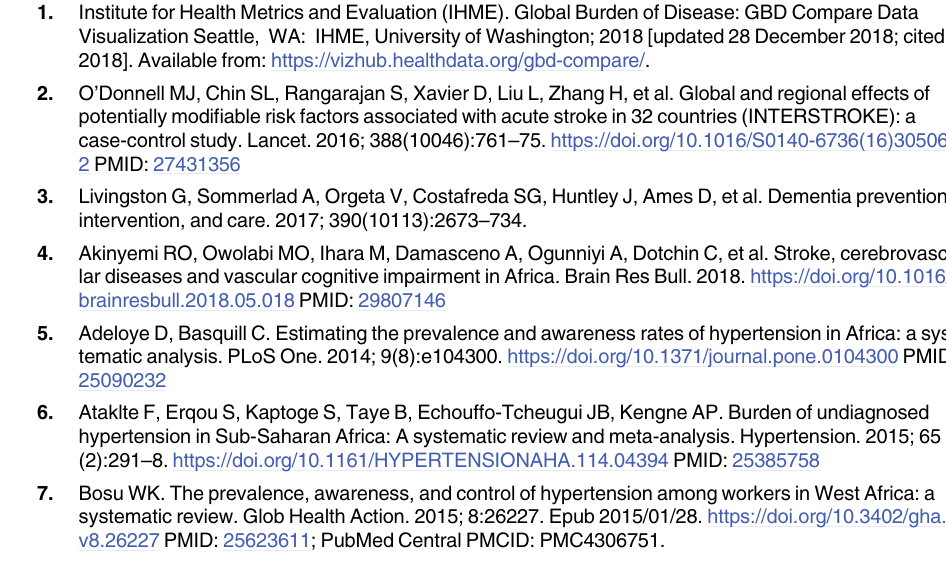
S3 Fig. Influence analysis omitting one study at a time from meta-analysis. S4 Fig. Funnel plot for studies on the prevalence of